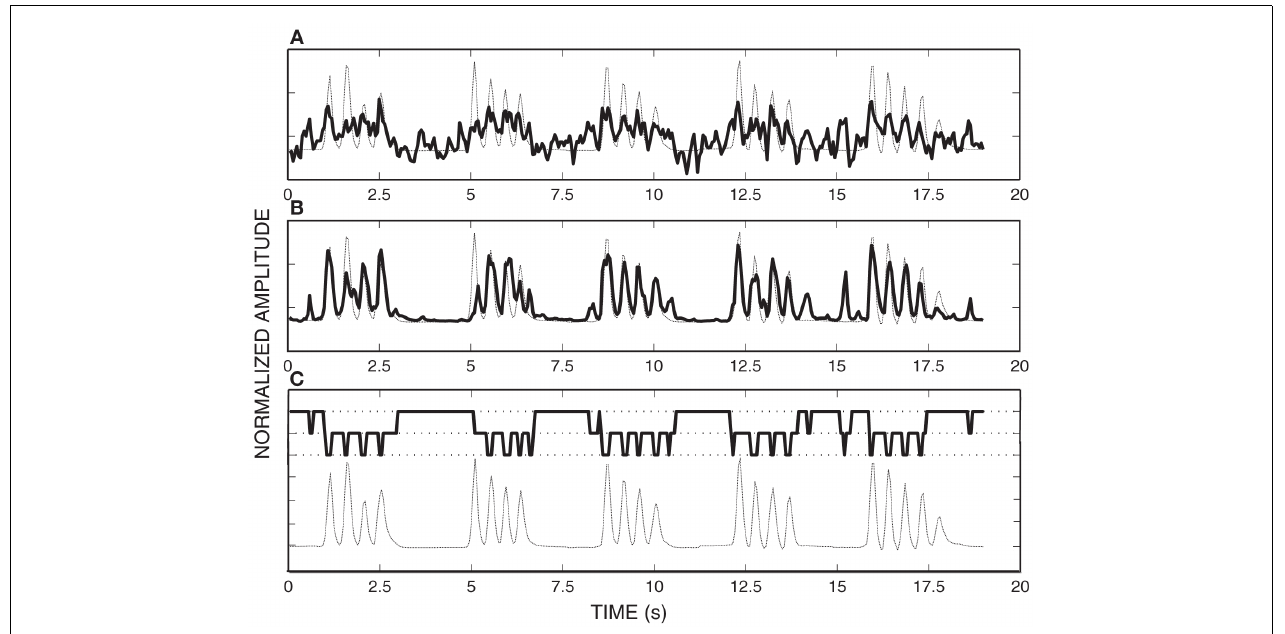
FIGURE 8 | (A) Actual finger flexion (dotted trace) and decoded finger flexion (solid trace) using pace regression (mean square error 0.68); (B) Actual finger flexion (dotted trace) and decoded finger flexion (solid trace) using SNDS (mean square error 0.40); (C) Actual finger flexion (dotted trace) and state prediction (solid trace).